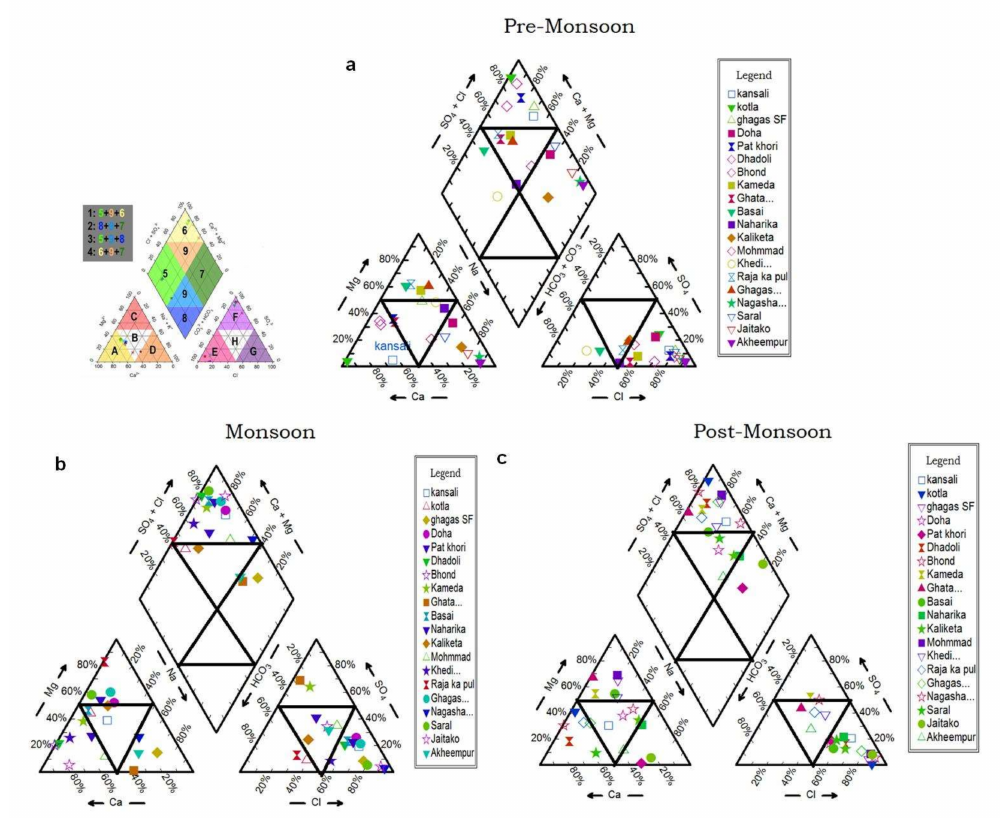
Figure 6. HREEQC modle. Piper trilinear diagram [16] of the groundwater water samples for ( a ) pre-monsoon ( b ) monsoon ( c ) post-monsoon. 1—calcium chloride type; 2—magnesium bicarbonate type; 3—sodium bicarbonate type; 4—sodium chloride type; 5 and 6—mixed type; A—mixed type; B—magnesium; C—sodium; D—calcium type, E—mixed, F—sulphate; G—bicarbonate;